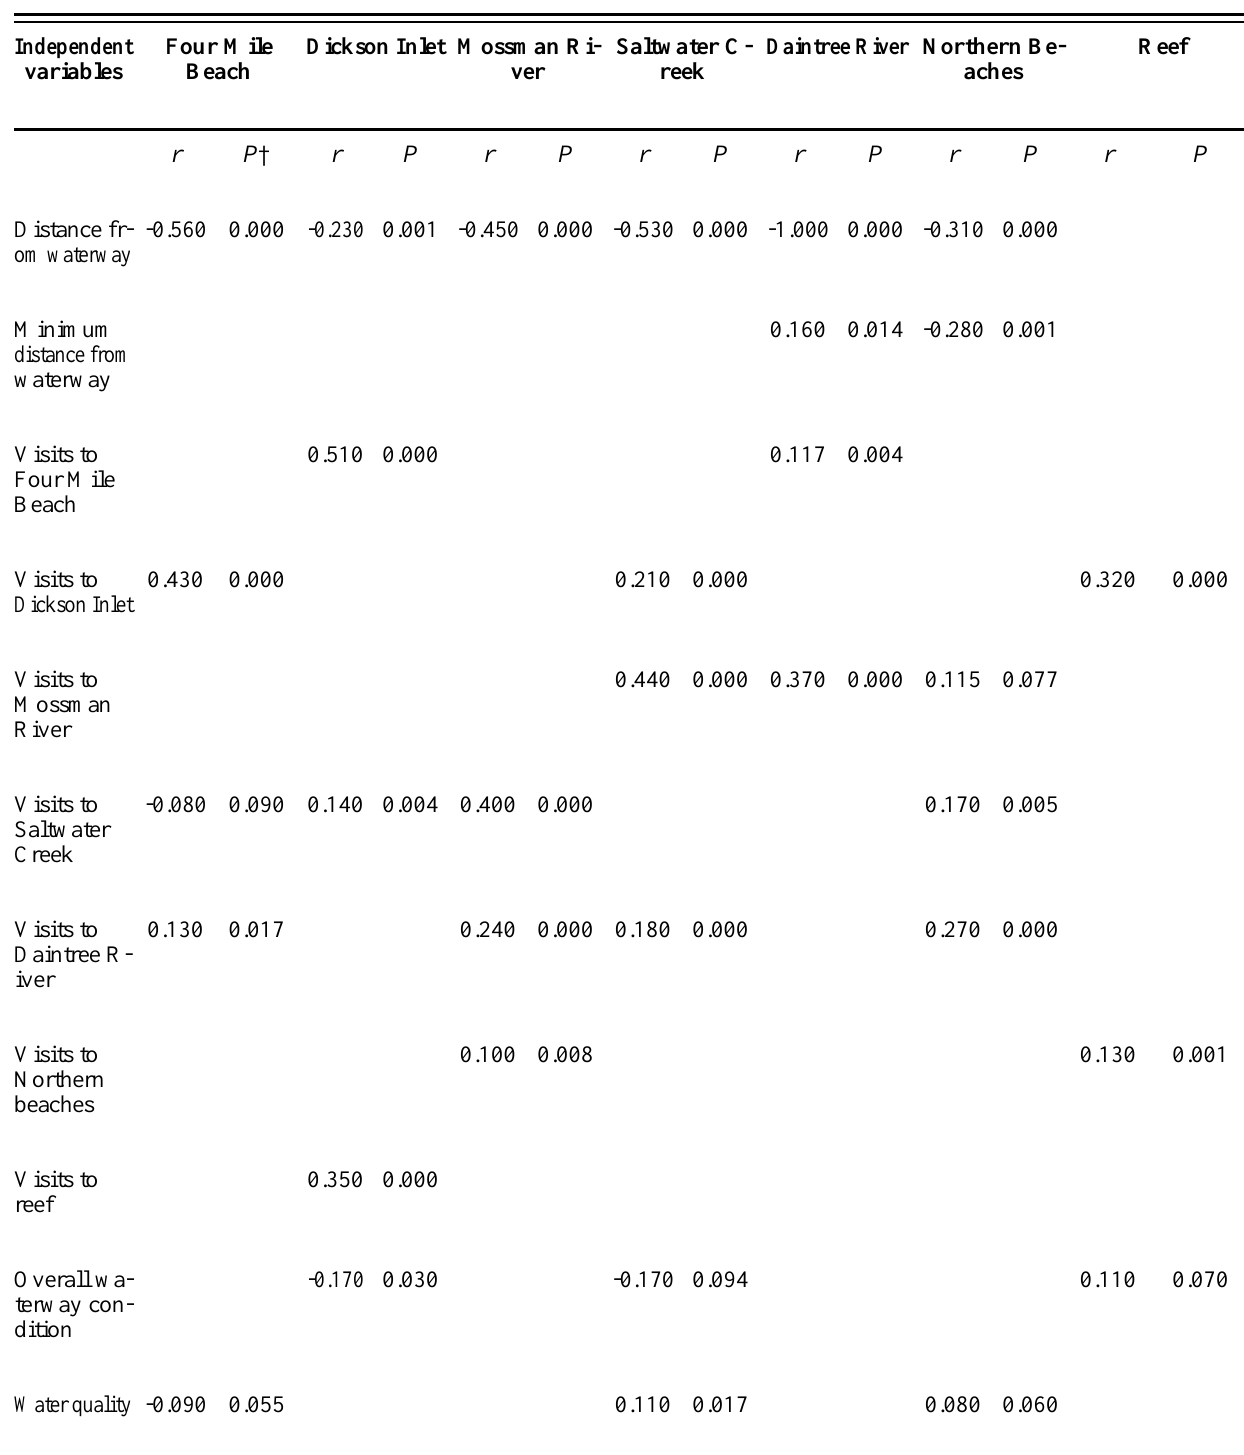
Table 8. Regression coefficients ( r ) and P values for recreational visits to waterways, Douglas